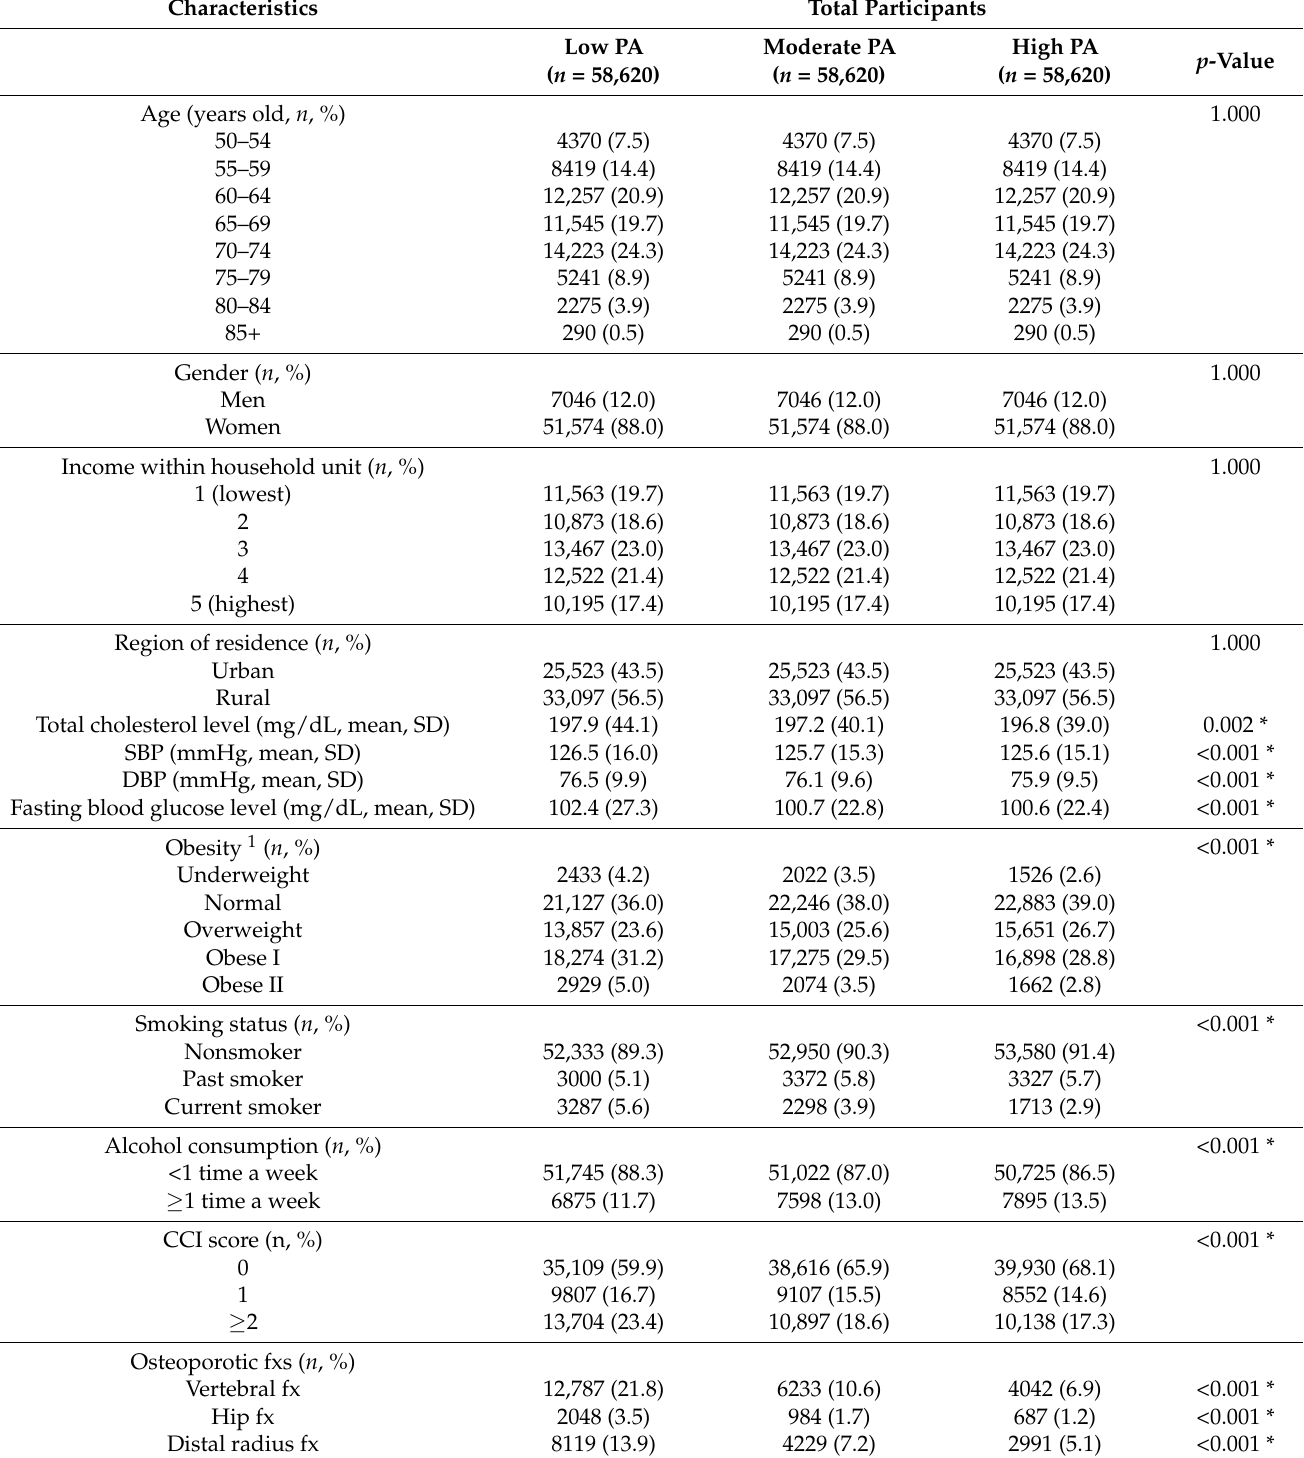
Table 1. General characteristics of